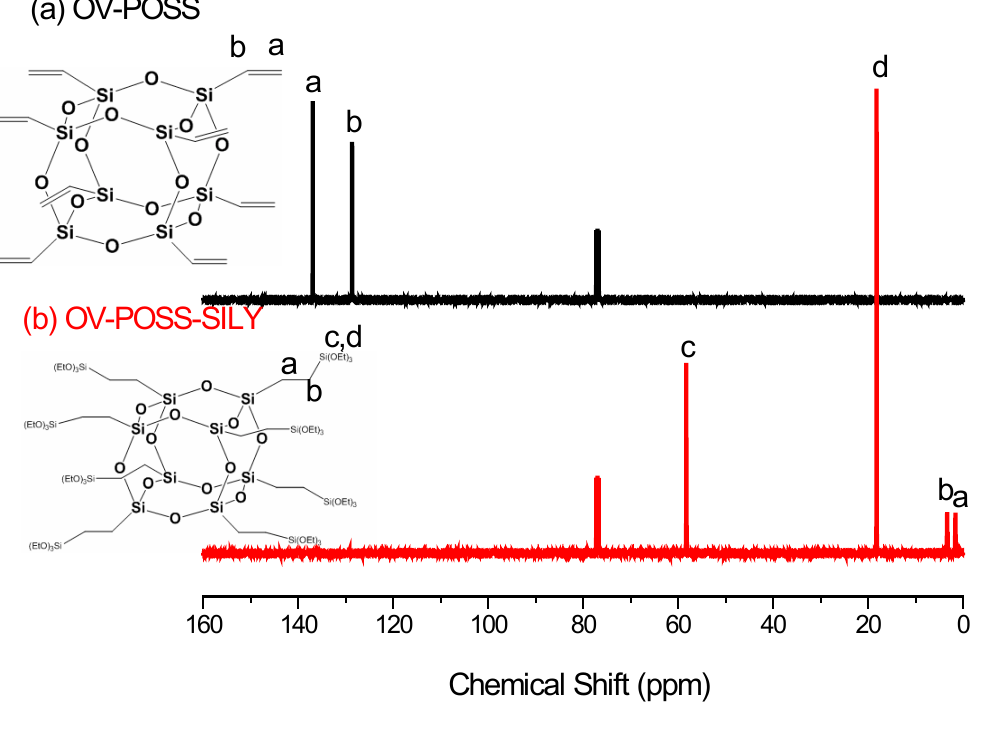
Figure 2. 13 C NMR spectra of OV-POSS and